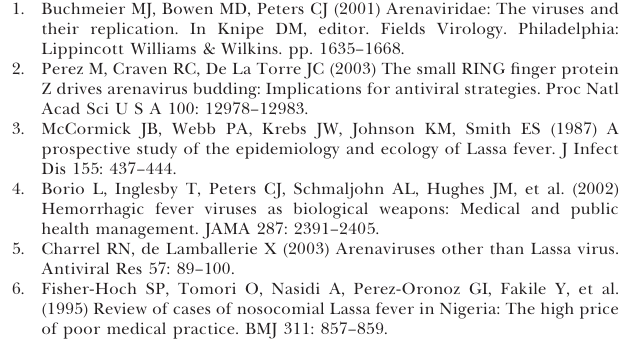
Figure S7. Indistinguishable CTL Response to LCMV-ARM and rLCMV-ARM* Infection (A) C57BL/6 mice were infected i.v. with 10 5 PFU LCMV-ARM or rLCMV-ARM* and were killed on day 9 (same experiment as in Figure 5C). The frequency of GP33- and of NP396-specific CD8 þ T cells in the spleen of mice was determined by MHC class I tetramer